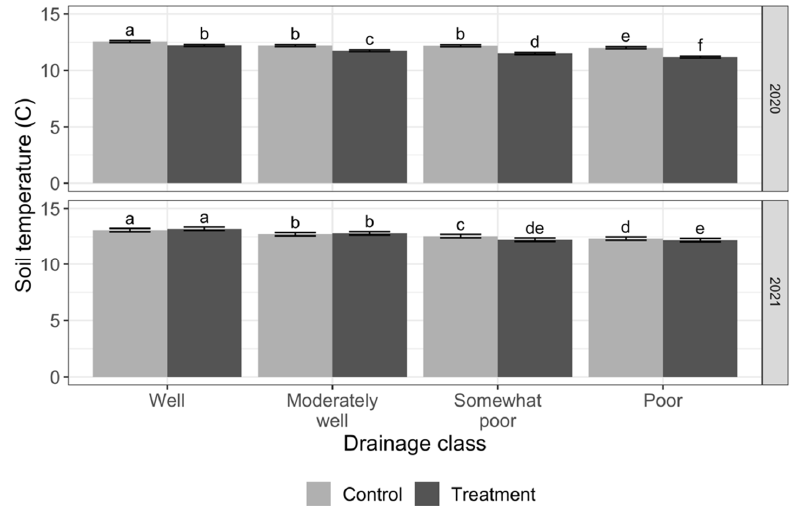
Figure 3. Mean soil temperature by drainage class and treatment for the growing seasons of 2020 and 2021. The letters indicate significant differences ( p -value < 0.05) among the drainage classes within each year.